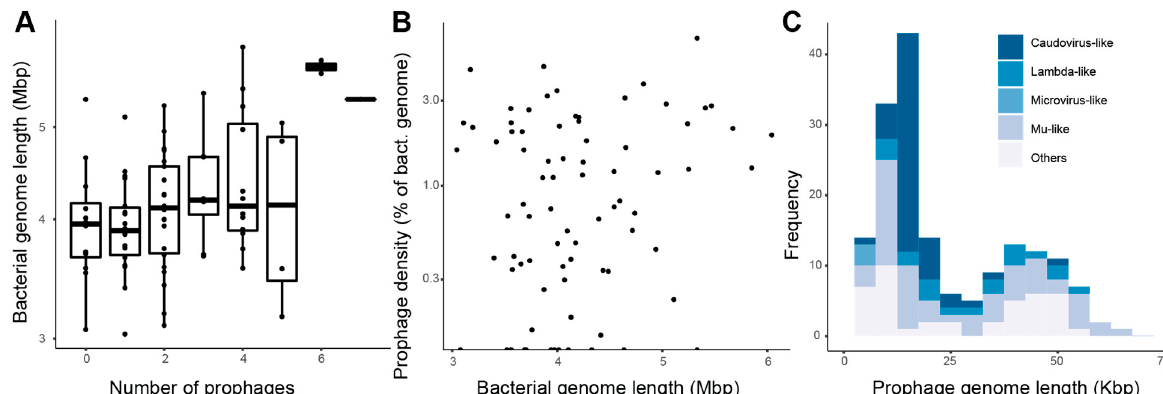
Figure 1. Prophages are widespread in roseobacter genomes . ( A ) Relationship between bacterial genome length and the number of putative prophages per genome. The horizontal line in the middle of each box represents the mean and the upper and lower bounds of the box represent the 75th and 25th percentiles. ( B ) Relationship between prophage density (sum of prophage lengths per each bacterial genome divided by bacterial genome length, plotted in log scale) and bacterial genome length (Linear regression p > 0.05). ( C ) Length frequency of all 173 putative prophages (Hartigans’ dip test for unimodality p > 0.05). Prophages are grouped by predicted taxonomy based on individual gene annotations.